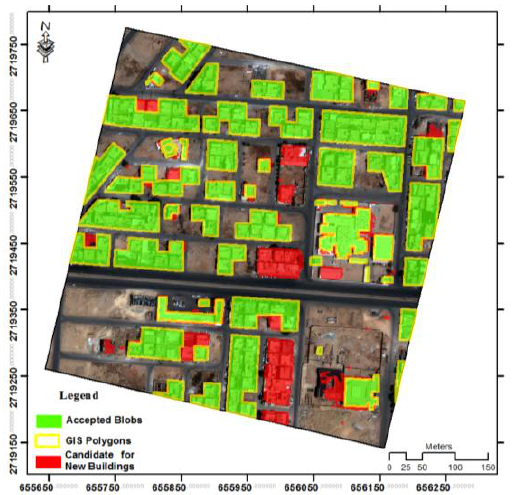
Figure 5. GIS polygons (yellow), verified buildings (green), blobs representing new construction (red), superimposed to one GeoEye image